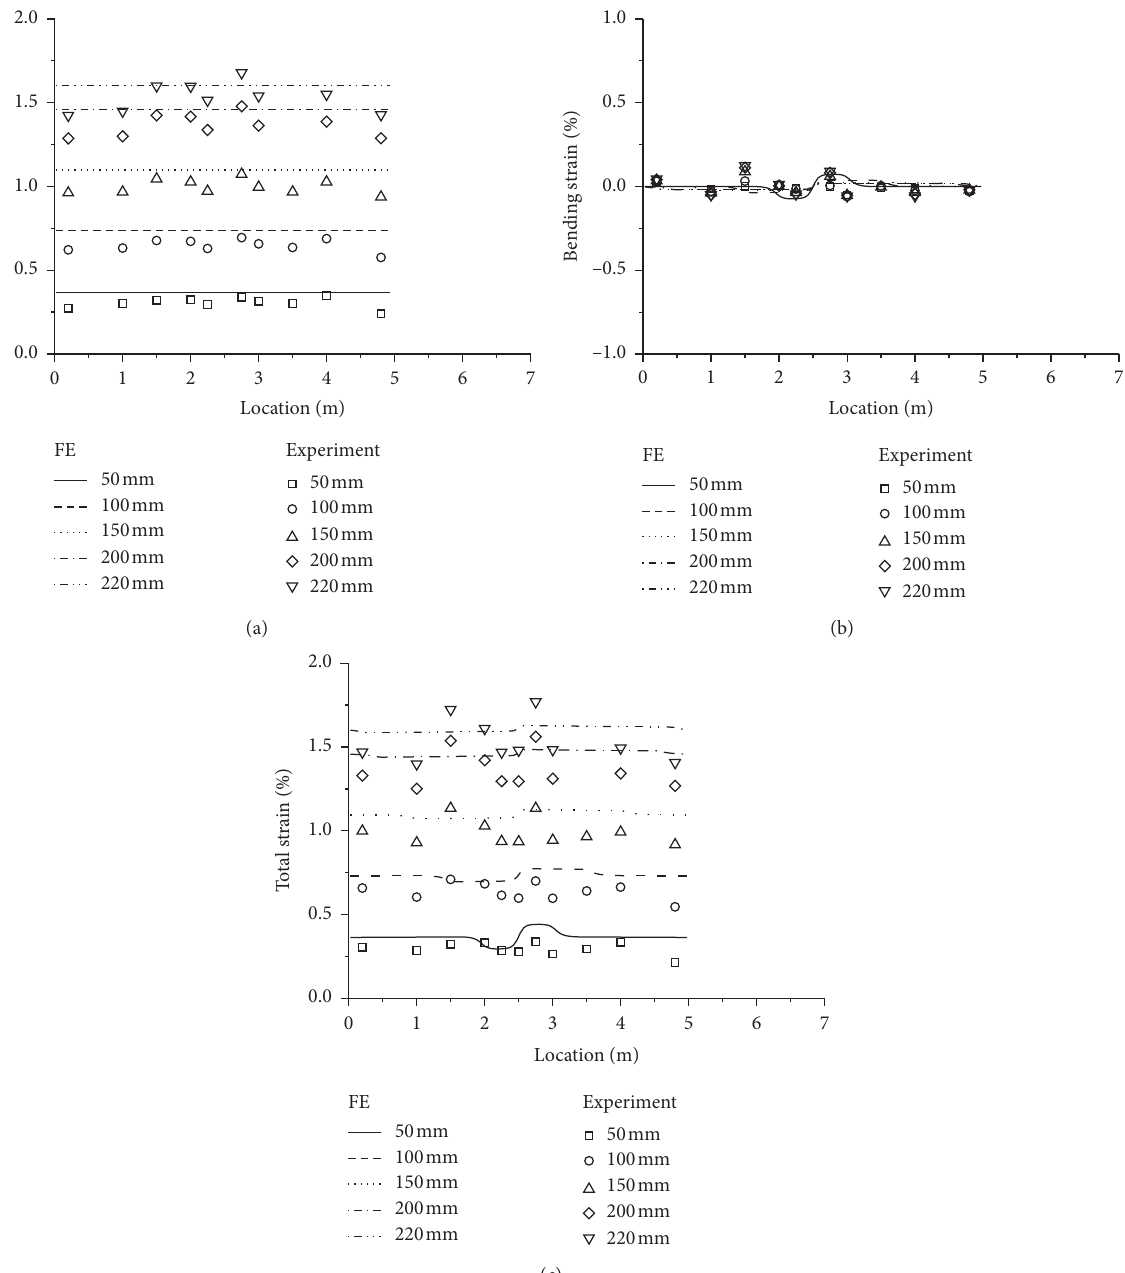
Figure 5: Comparison between finite element results and full-scale model test results: (a) axial strain; (b) bending strain; (c) total